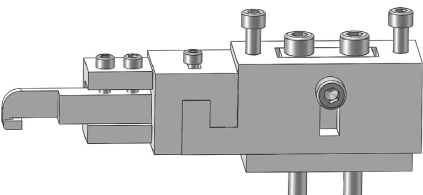
Figure 1: Schematic diagram of tool installation adjustment seat on the spring forming machine.